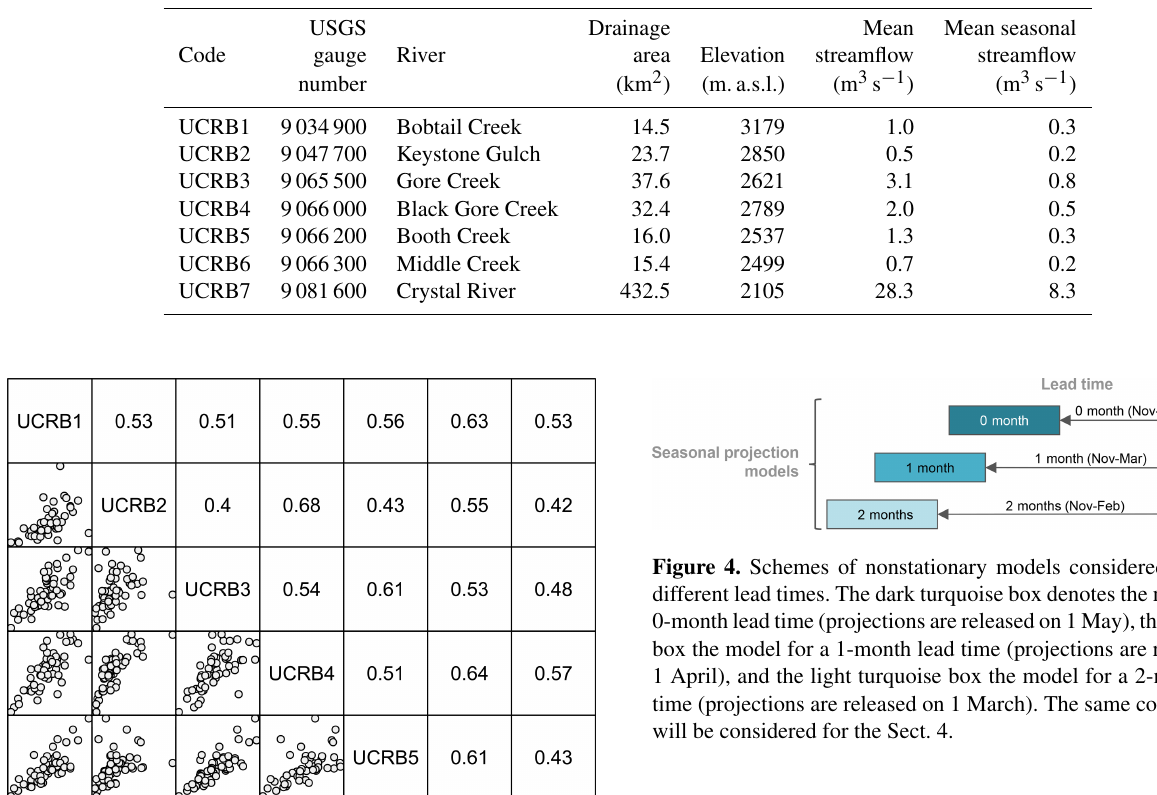
Table 1. Basic data corresponding to the streamflow gauges in the Upper Colorado River basin (UCRB) considered in this study.